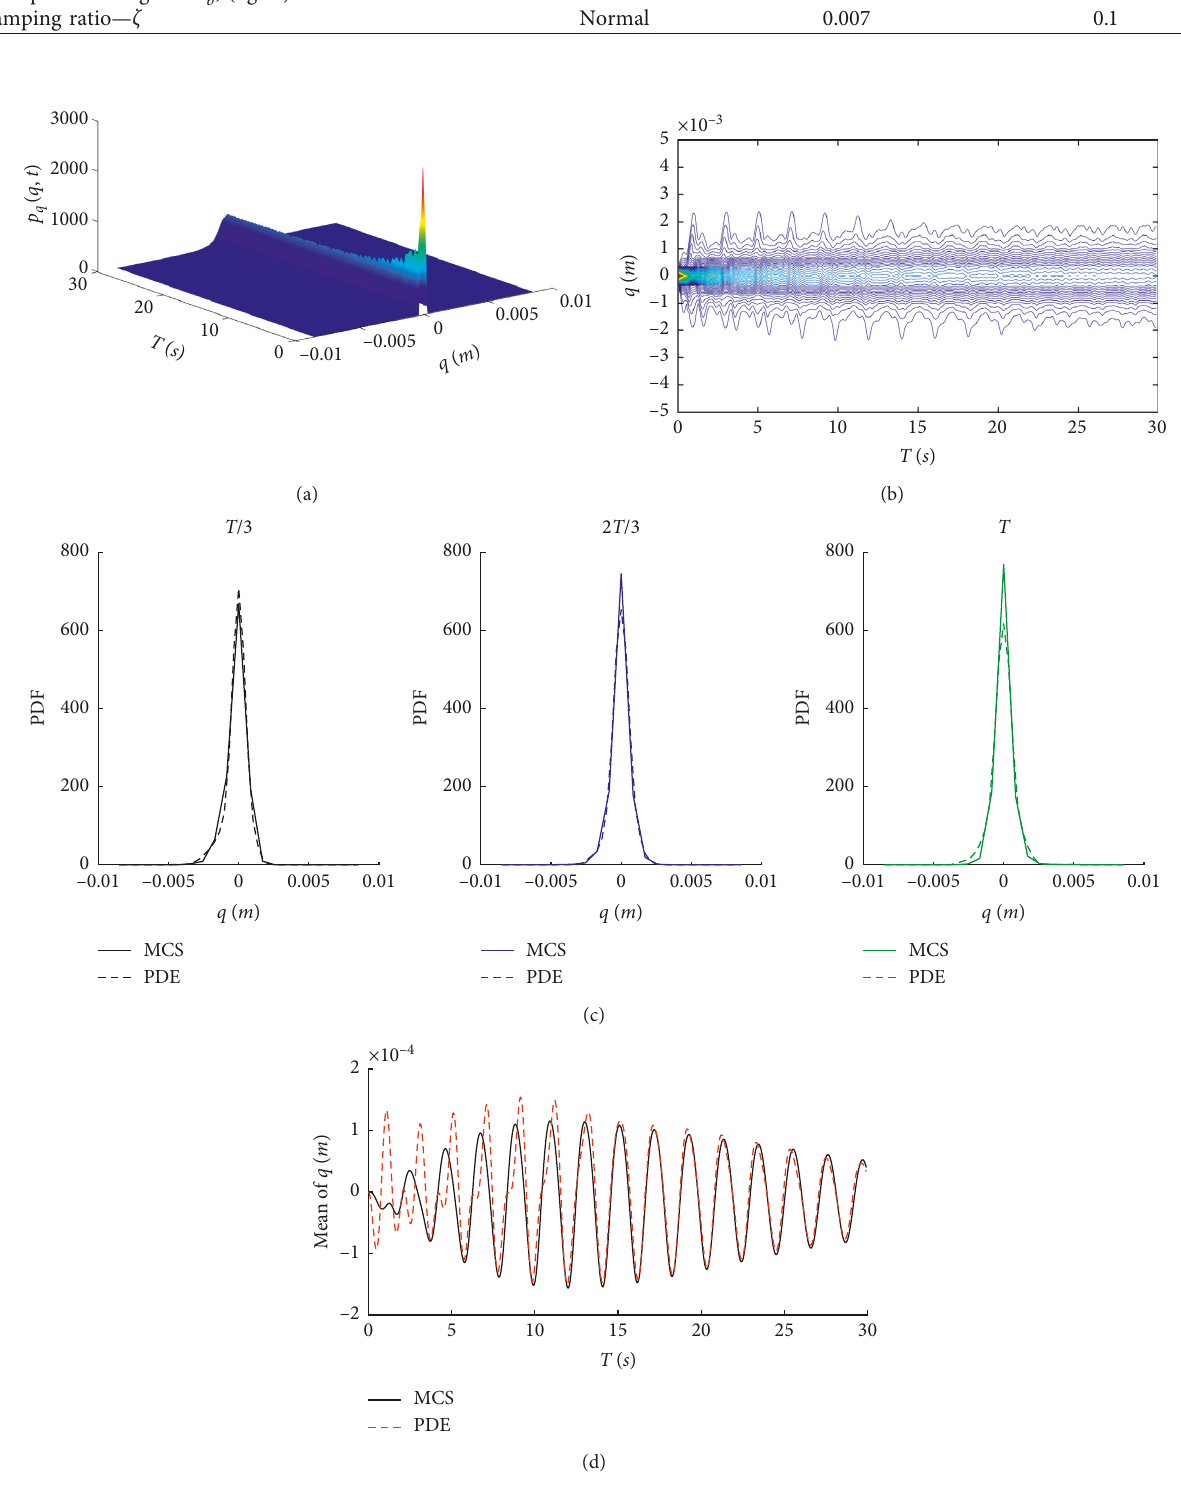
Figure 5: Probability results of the lateral displacement ( N during evolution. (c) PDFs at different time instances. (d) Mean values of